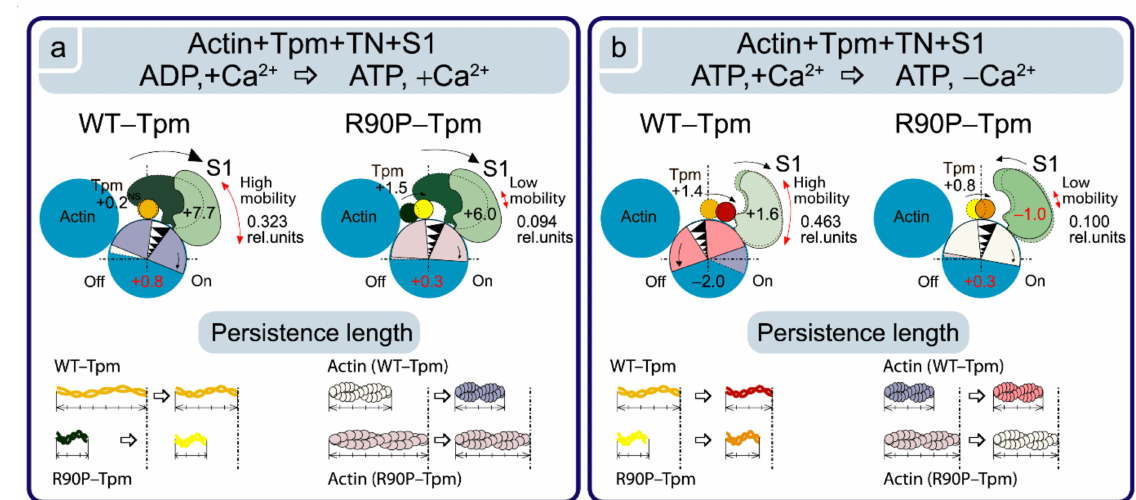
Figure 6. Schematic view of the alterations in the Tpm position, conformational rearrangements in actin and S1, and the changes in the persistence lengths of the Tpm strands and actin filaments due to the R90P substitution in Tpm, as follows from the polarized fluorimetry data. The changes in the value for Φ E are interpreted as the shift of Tpm relative to the inner and outer domains of actin, the rotation of actin monomers in the actin filament and the azimuthal tilt of the myosin motor domain. The left and right panels show the transition of the Actin-Tpm-TN-S1 complex from the state in the presence of ADP at a high Ca 2+ to the state in the presence of ATP at a high Ca 2+ ( a ), and further to the state at a low Ca 2+ concentration ( b ). The mutant Tpm strands have a lower persistence length and are shifted towards the inner domains of actin as compared with WT-Tpm. The persistence length changes are drawn to scale. The mutation increases the persistence length of actin, inhibits the actin monomer rotation, and causes the switching of actin monomers off at the transition from the state in the presence of ADP to that in the presence of ATP and the switching of actin monomers on at a low Ca 2+ . The abnormal position of the mutant Tpm induces the appearance of the myosin heads strongly bound to actin under relaxing conditions. The mobility of the myosin heads is decreased in the presence of the mutant Tpm, as follows from the calculation of the number of the disordered probes (parameter N). Designations are the same as in Figure 5. Different conformational states of the myosin head are depicted by different shades of